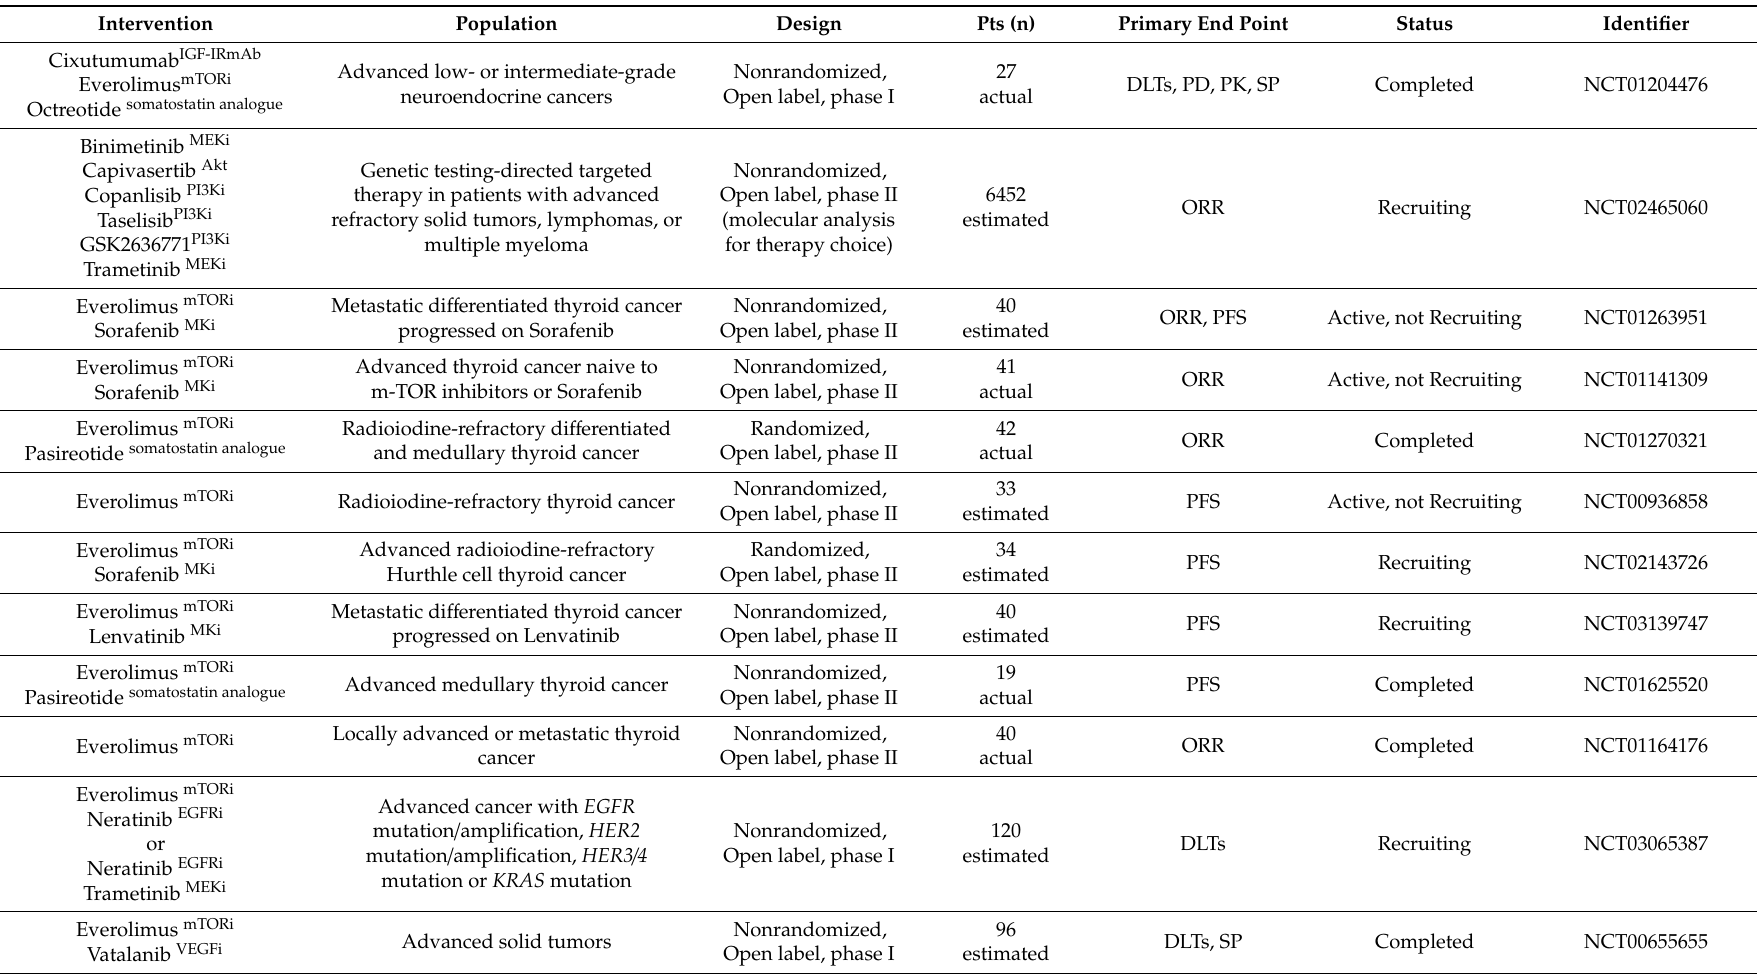
Table 2. Ongoing or completed yet unpublished clinical